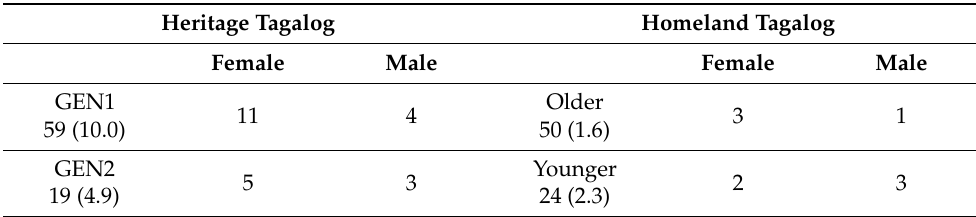
Table 2. Participant sample. Mean age (and standard deviation), in years, shown for each group.